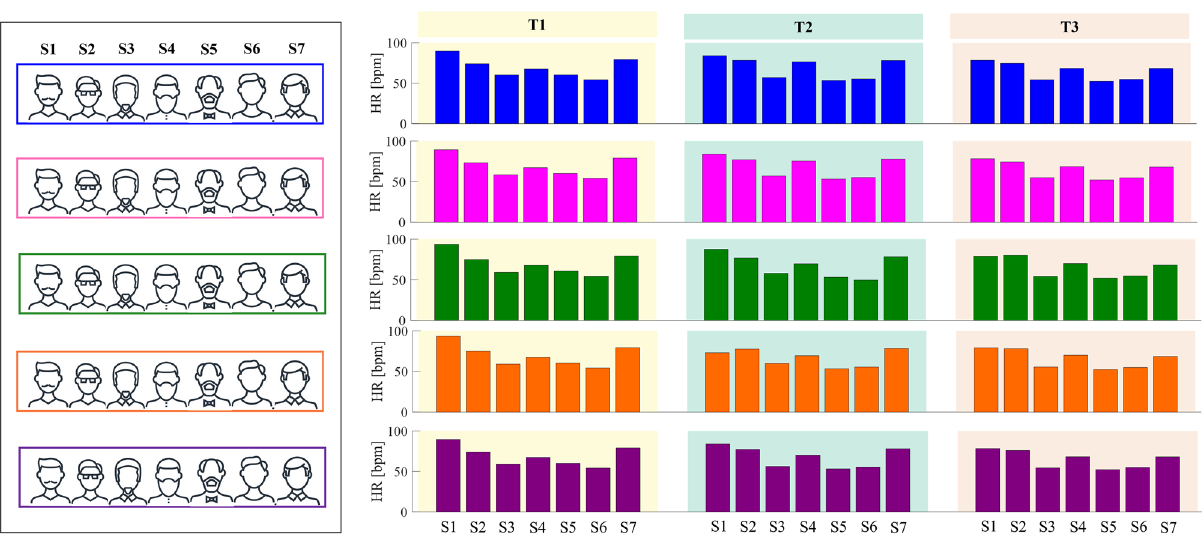
Figure 7. Schematic of the approach used to group the HR data considering a single